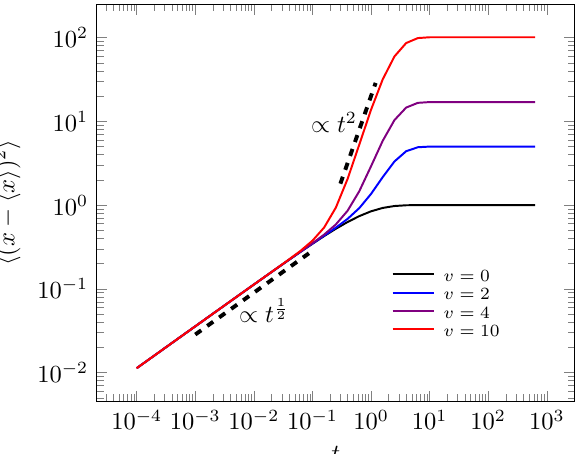
= 1 and = 1. K x K y